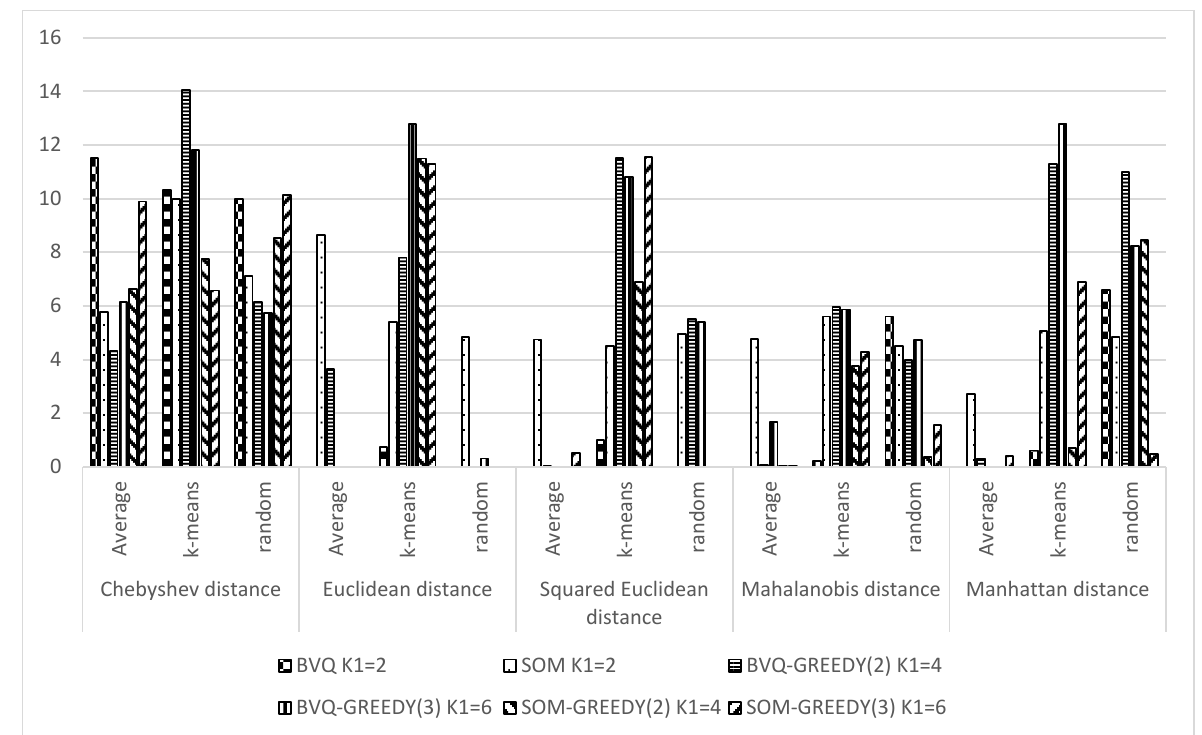
Figure 4. Coefficient of variation of the objective function value for the three ‐ batch mixed lot.